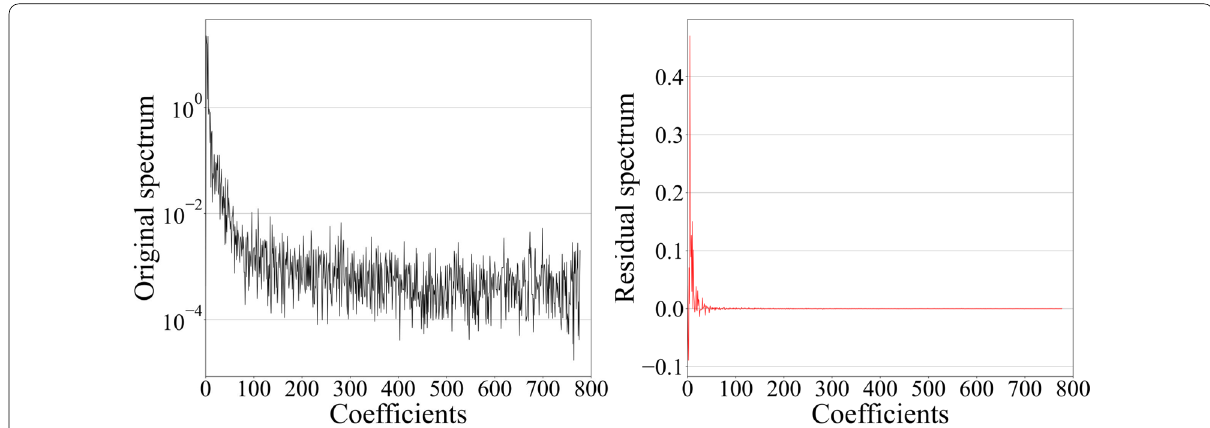
Fig. 12 The original power spectrum (left) and the residual power spectrum (right). Coefficients are ordered with respect to the corresponding eigenvalues of the Laplace-Beltrami